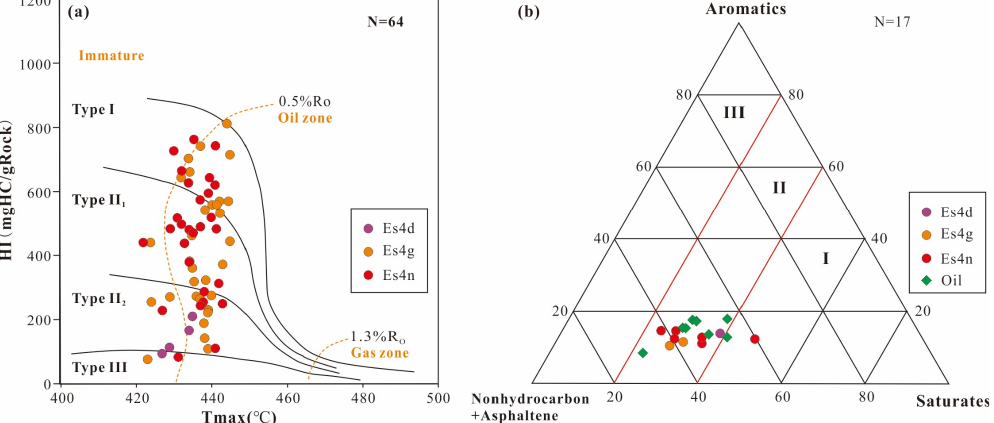
Figure 8. Classification plots of the Es4d, Es4g, and Es4n source rock types in the Niuxintuo area. ( a ) Cross plots of T max versus HI. ( b ) Triangle diagram of the hydrocarbon group components.